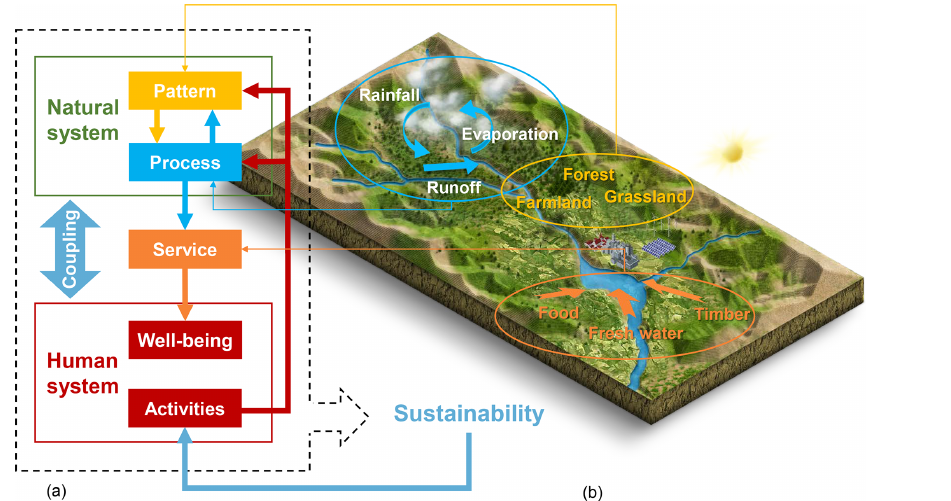
Figure 1. Illustration of the pattern–process–service–sustainability framework. A flowchart of the pattern, process, service, and sustainability framework in the coupled human and natural system (a) and a diagram of typical patterns, processes (e.g. hydrological processes), and ESs (e.g. provision services) (b)